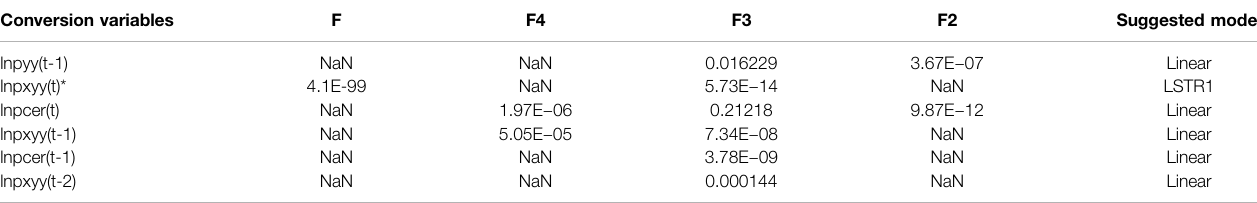
TABLE 4 | Non-linear test results.